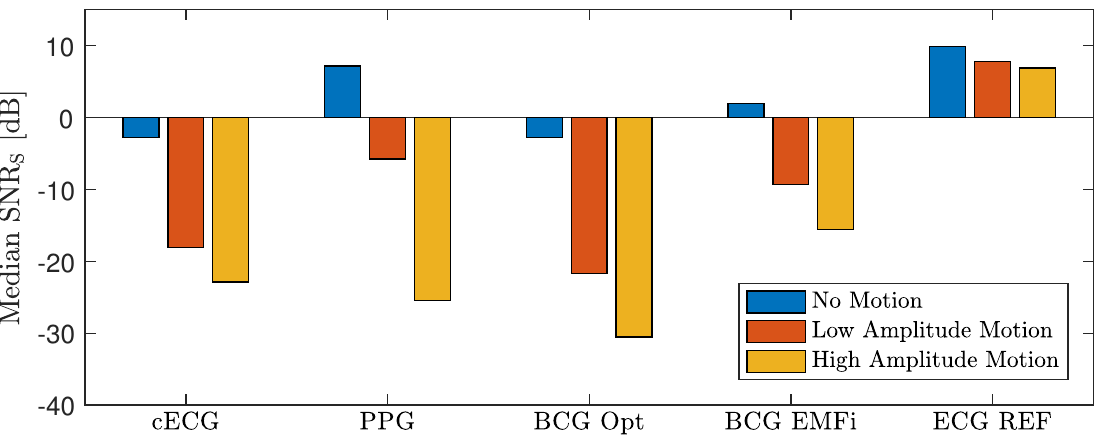
Figure 10. Median SNR S for all subjects and maneuvers for the three scenarios “no motion”, “low amplitude motion” and “high amplitude motion”.